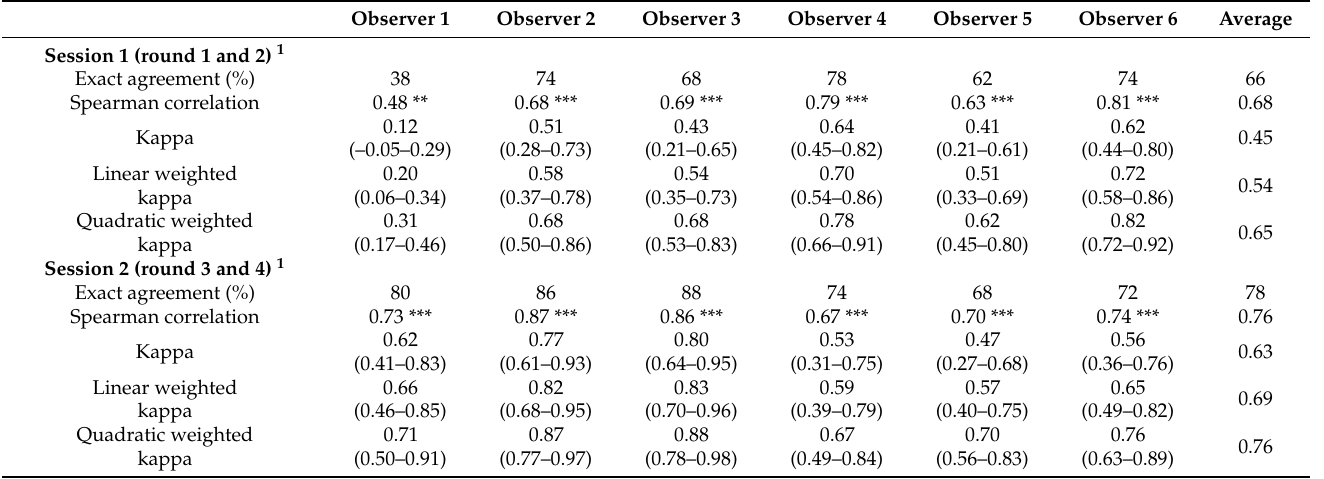
Table 1. Intra-observer reliability coefficients of white striping scoring of turkey breast muscle (0–3 scale) to assess agreement within 6 observers over multiple training sessions. The 95% confidence interval for kappa, linear weighted kappa, and quadratic weighted kappa are given below the coefficients in